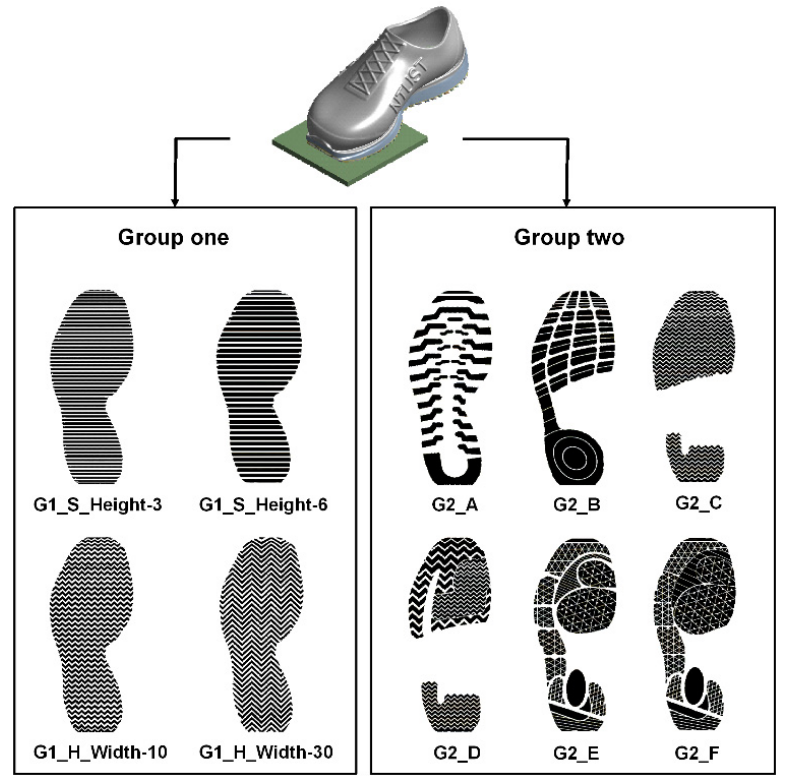
Figure 2. A 3D shoe model, and ten types of tread pattern design.